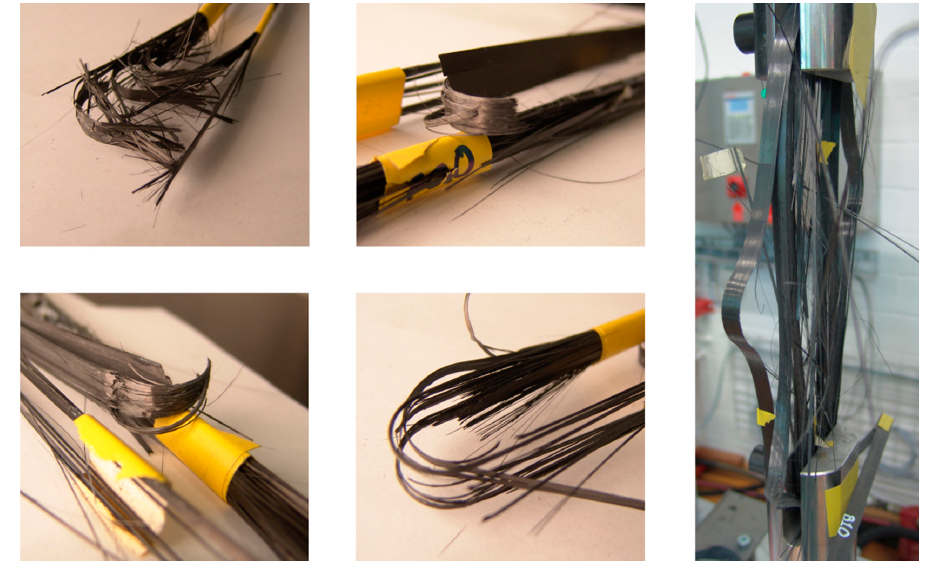
Figure 6. Damage modes in different fretting fatigue loaded straps.